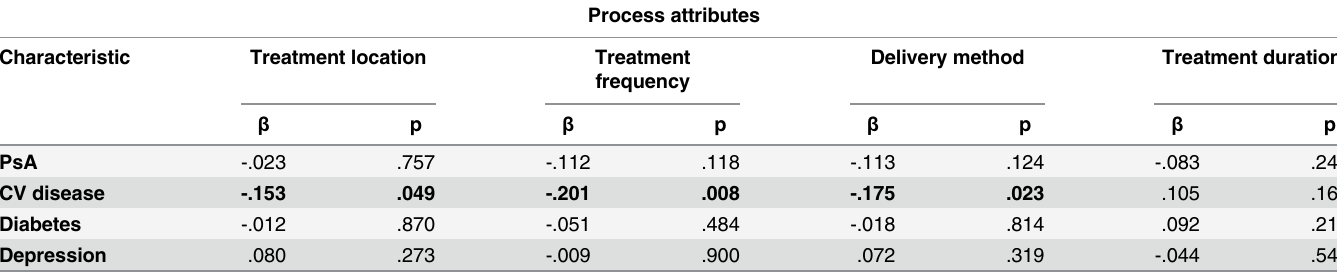
Table 3. Multiple linear regression models showing the influence of comorbidities on process